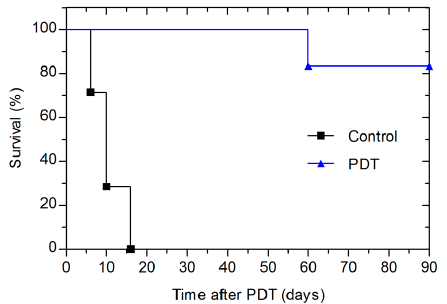
Figure 3. Kaplan Meier plot for BALB/c animals with CT26 untreated tumours and tumours treated with PDT with total light doses of 74 J/cm 2 (130 mW) at 15 min after 1.5 mg/kg of redaporfin administration.